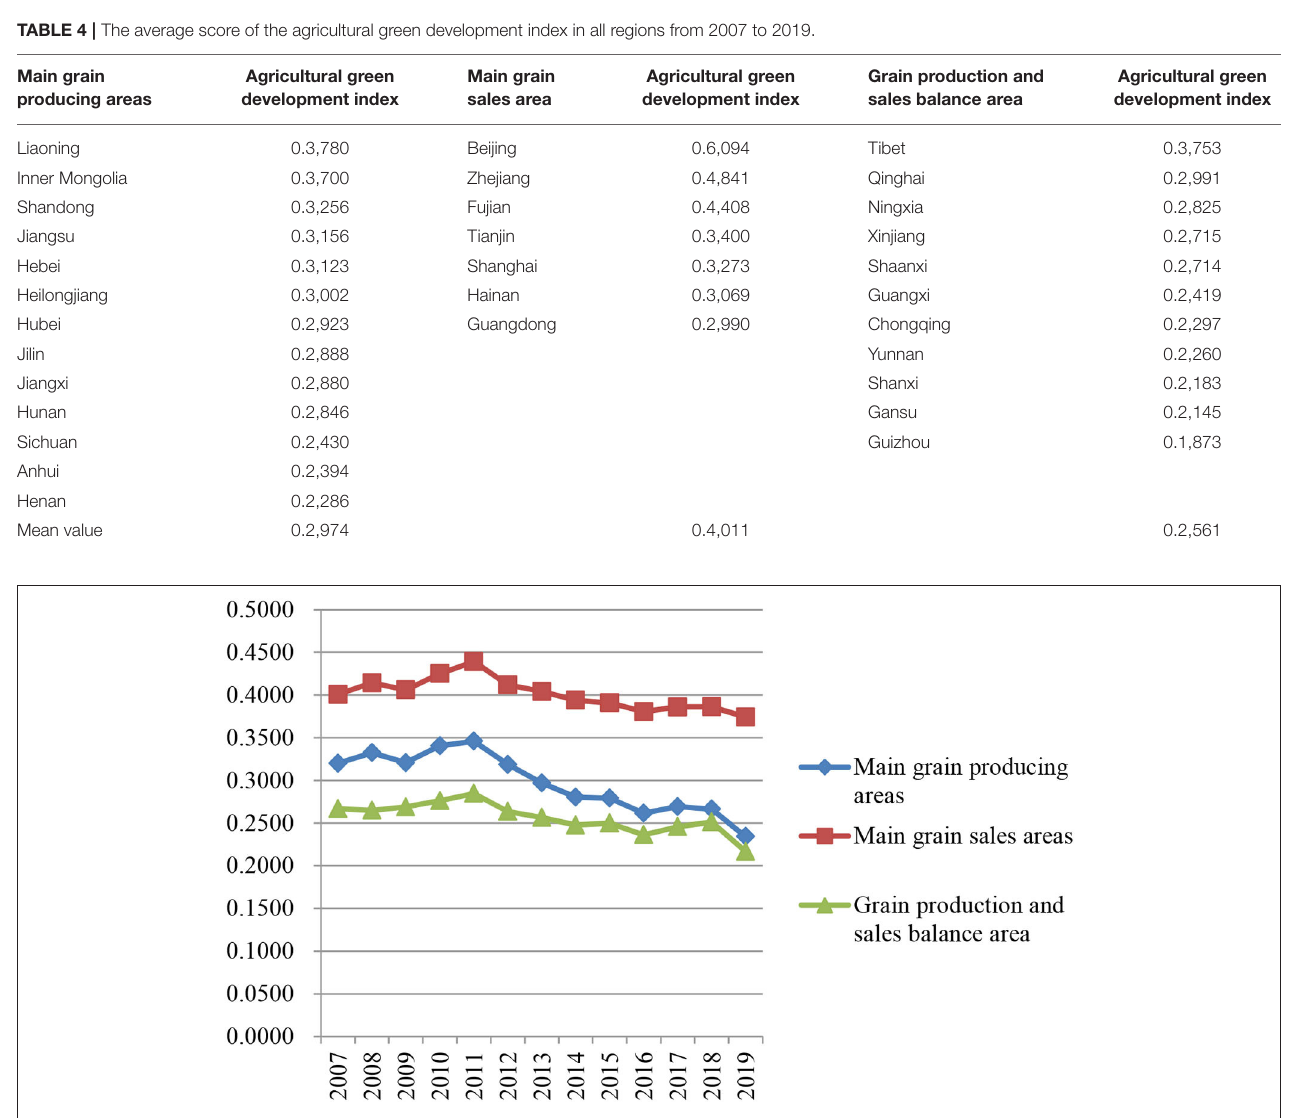
FIGURE 2 | The development trend of the agricultural green development index in three functional areas of grain production in China